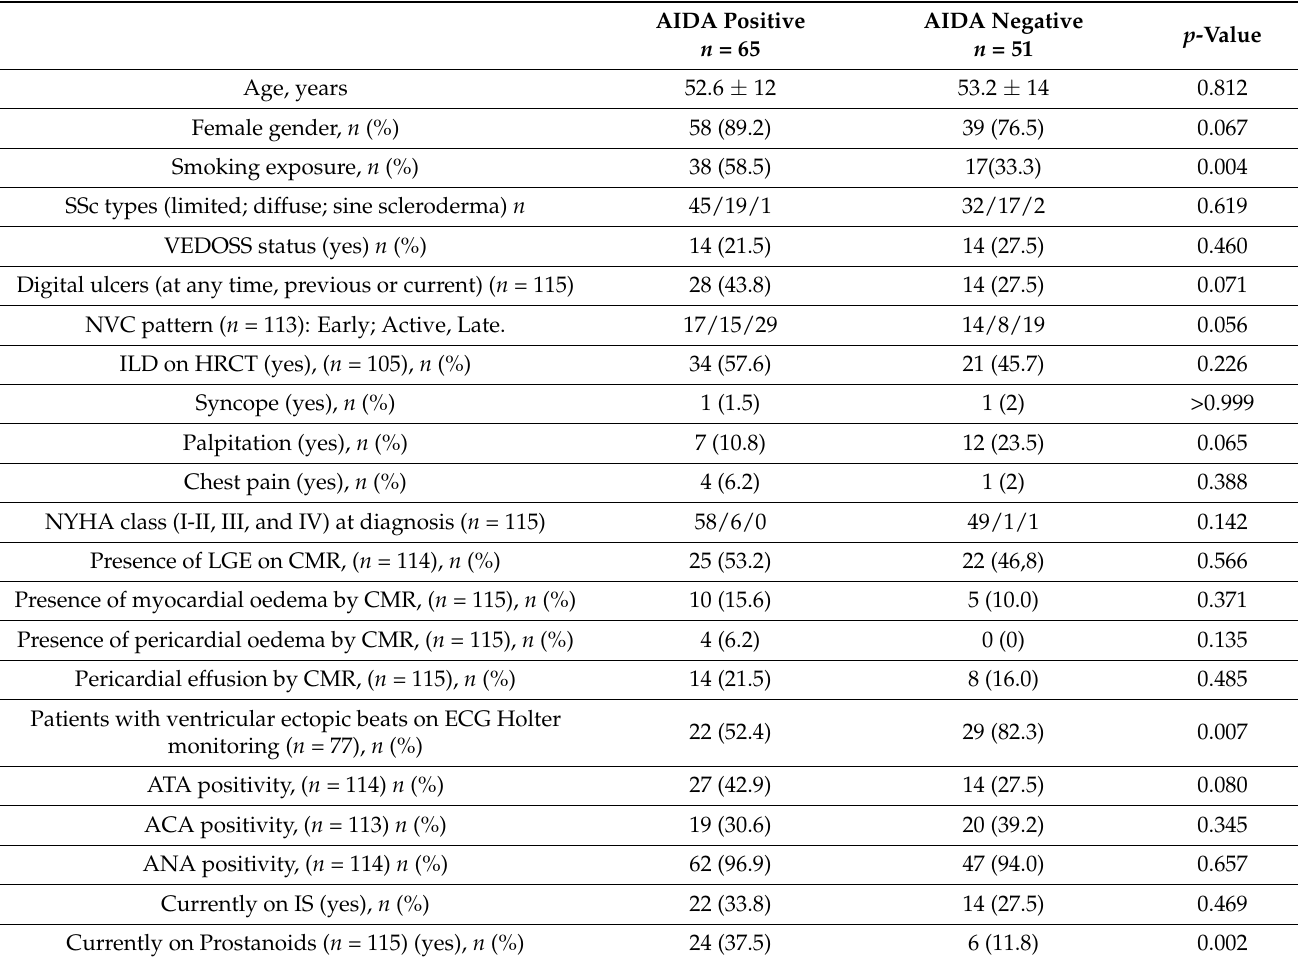
Table 3. Demographic, clinical, imaging, and immunological characteristics of patients according to AIDA